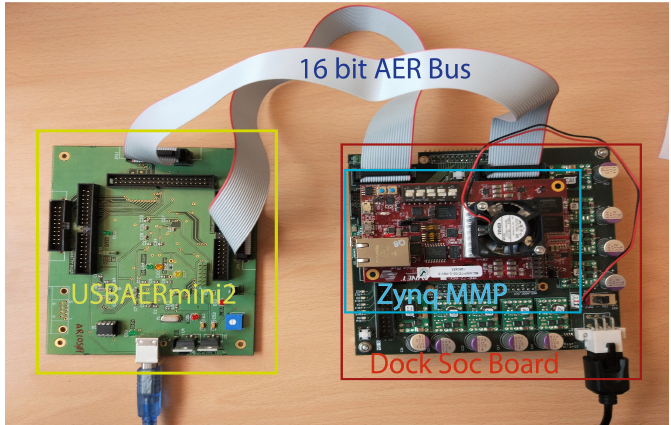
Figure 9. Experimental Setup. Left : USBAERmini2 that sends and receives events from FPGA. Right : Zynq MMP board with F-HOTS architecture implemented.